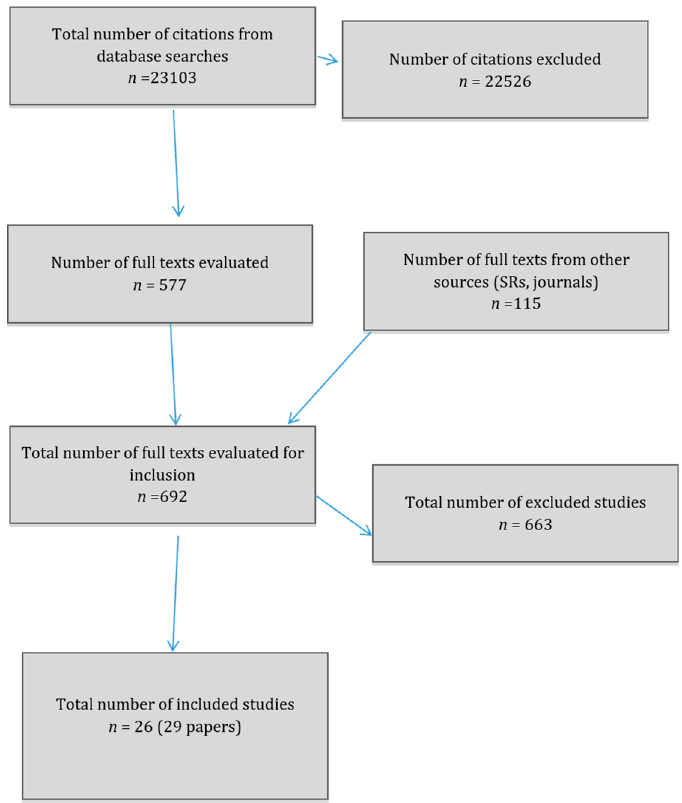
Figure 1. PRISMA* flow diagram. *Preferred Reporting Items for Systematic Reviews and Meta-Analyses